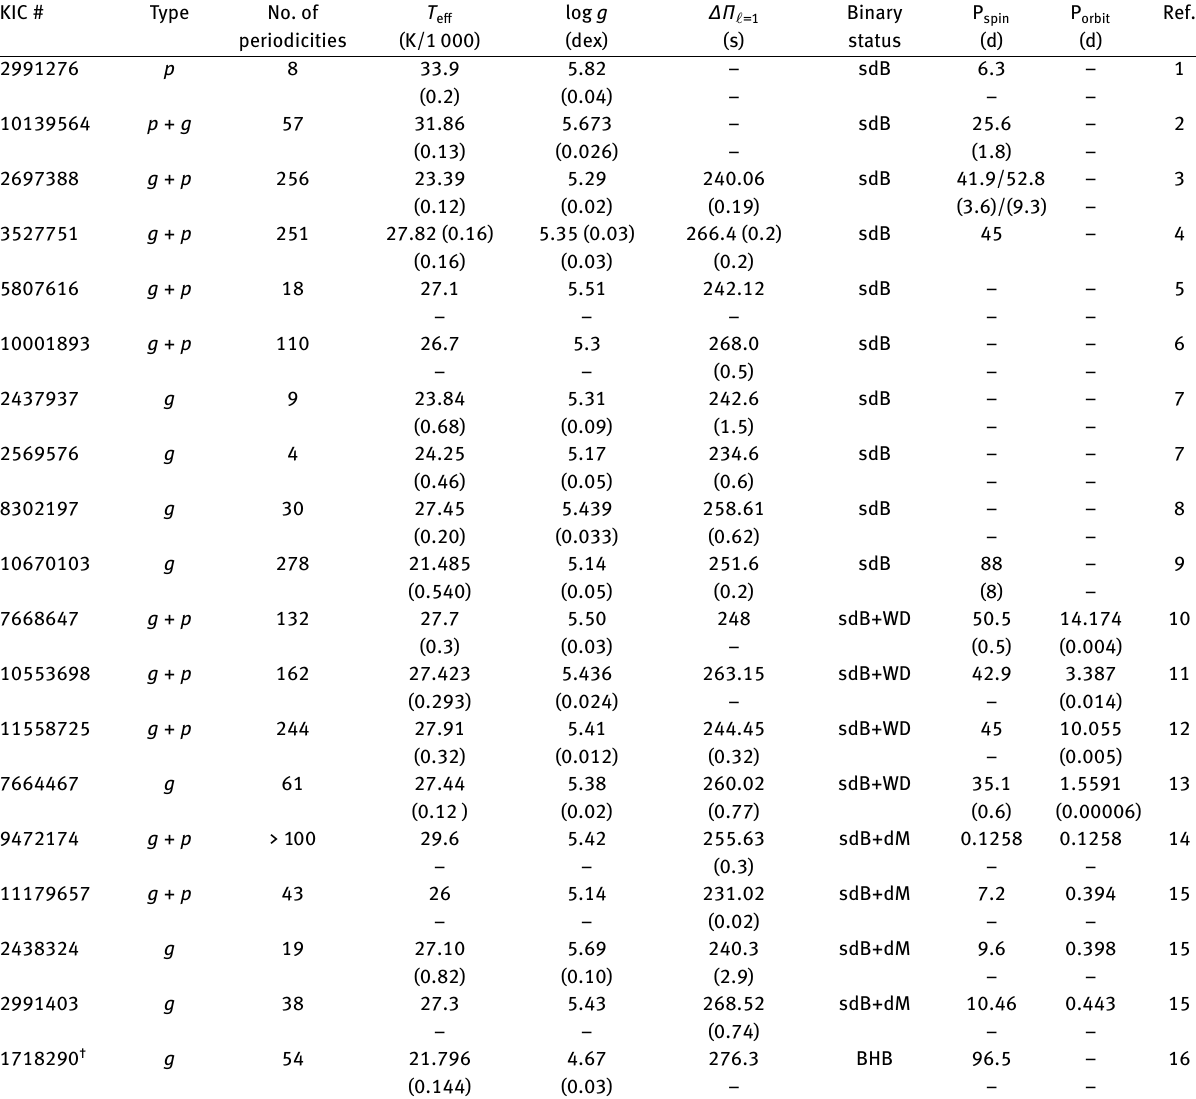
Table 1. Spectroscopic and seismic properties of Kepler-observed sdBV stars. Column 1 provides the KIC or EPIC identifications, column 2 the pulsation type where p are p −mode only pulsators, p + g are predominantly p mode hybrid pulsators, g are g −mode only pulsators, and g + p are predominantly g mode hybrid pulsators. Column 3 provides the number of pulsation periodicities, columns 4 and 5 provide spectroscopic properties, and column 6 the g −mode asymptotic period spacing for ℓ = 1. Column 7 provides the binary status where sdB is listed for single stars, sdB+WD for those with white dwarf companions, sdB+dM for those with M-dwarf main sequence compansions and sdB+F or sdB+G for those with main sequence F or G companions. Column 8 provides the rotation rate and if two values are given, the first is for the envelope and the second for deeper interior. Column 9 provides the binary period and Column 10 a reference. The